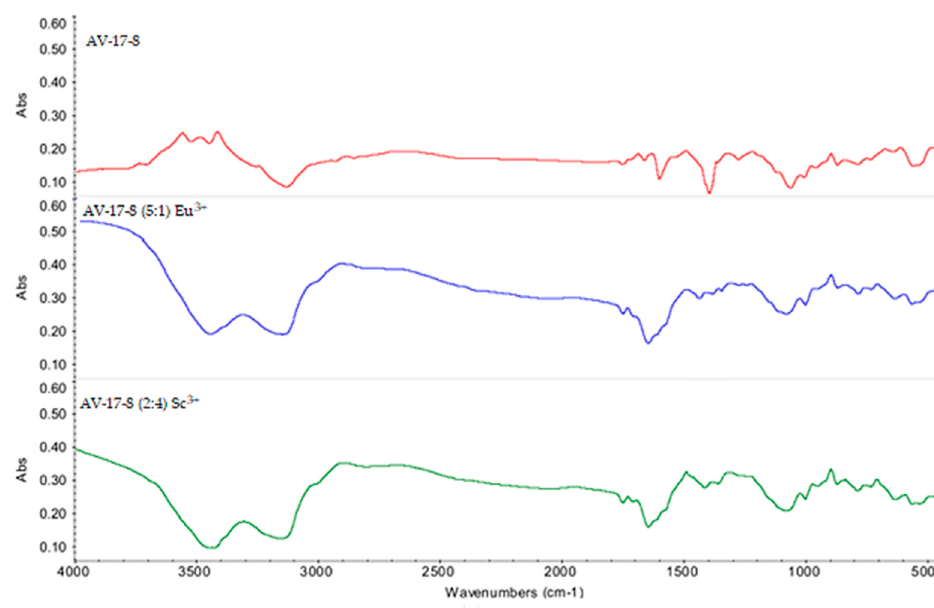
Figure 10. FTIR spectra: initial AV-17-8; AV-17-8 (5:1) (with sorbed Eu 3+ ) as part of the interpolymer system; AV-17-8 (2:4) (with sorbed Sc 3+ ) as part of the interpolymer system.